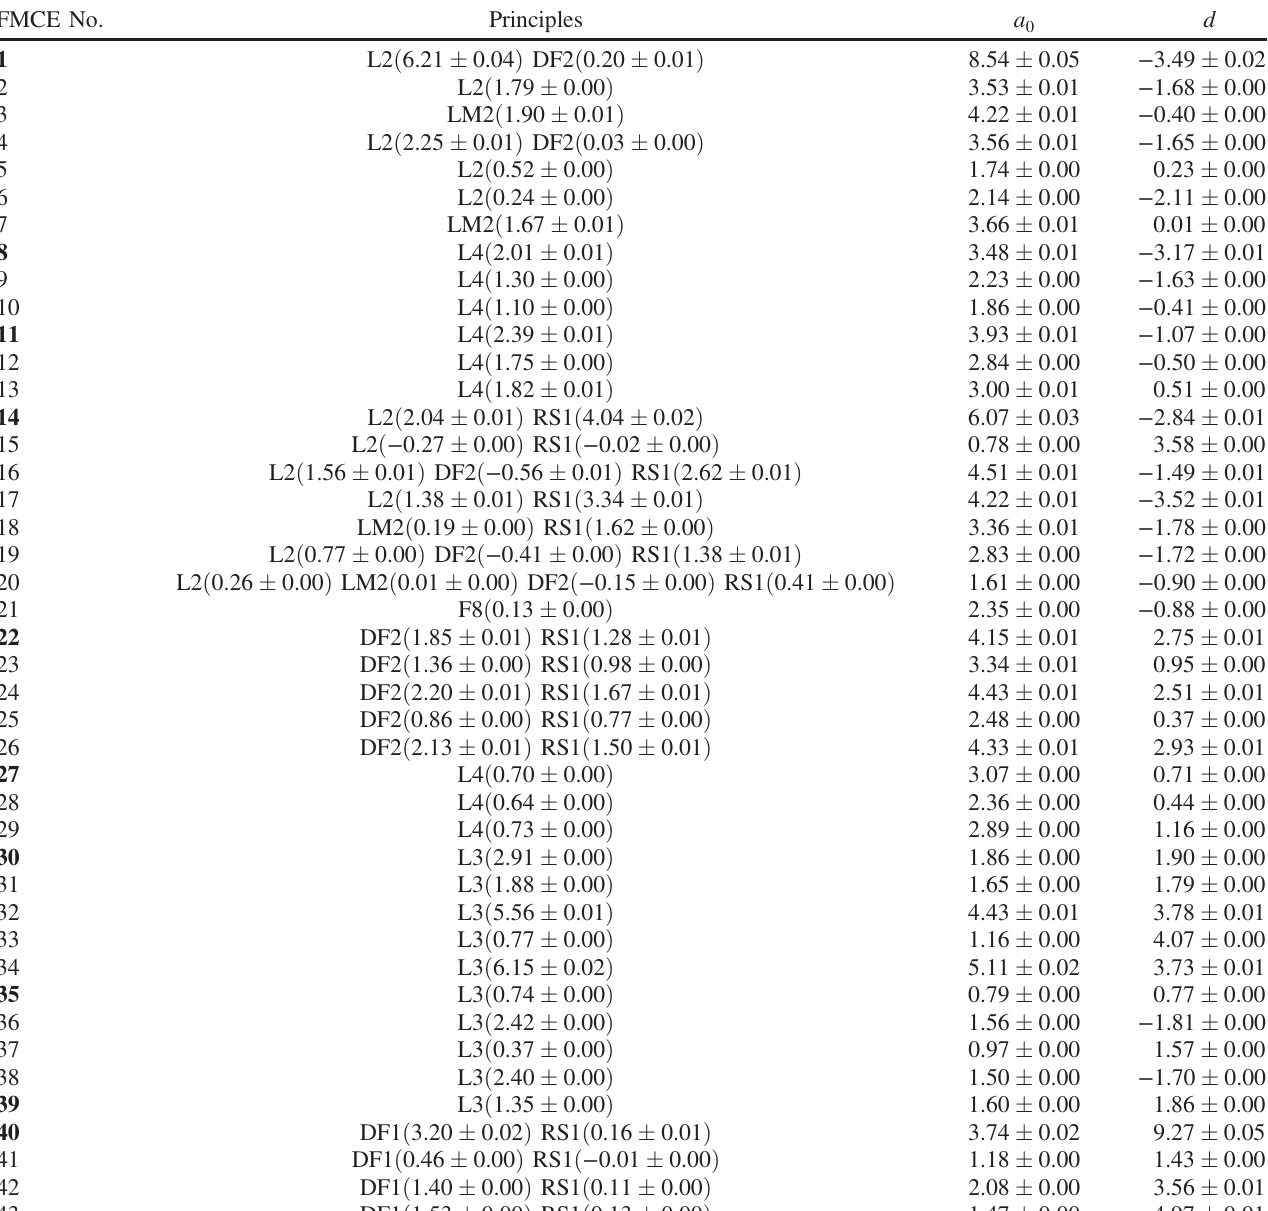
TABLE VI. Optimal MIRT model (model 8). The number in parenthesis is the discrimination a jk for the principle on the item. a 0 is the discrimination for a factor loaded on all items and d is the difficulty of the item. Values are presented as the mean (cid:3) the standard error of the mean. Items students find more challenging have smaller values of d . In general, well-functioning items will have a positive overall discrimination a 0 . Items measuring the principles identified in the expert model should have positive principle discriminations a jk that are substantially different from zero. Bolded item numbers represent the first item in an item block. FMCE